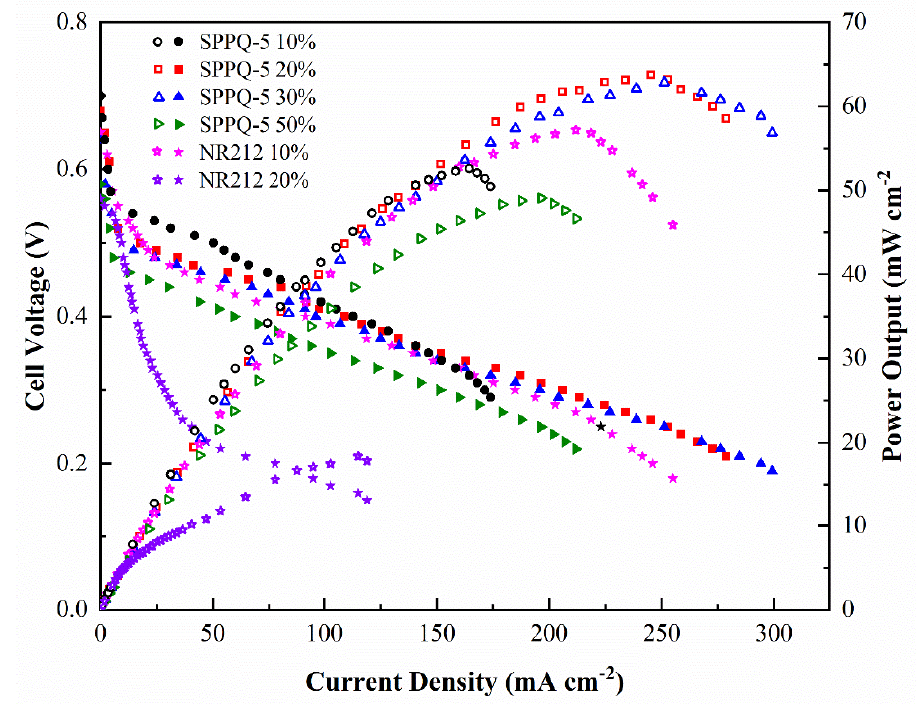
Figure 10. Effects of methanol feed concentration on DMFC performance with a supply of O 2 but without humidification and press at 60 °C.